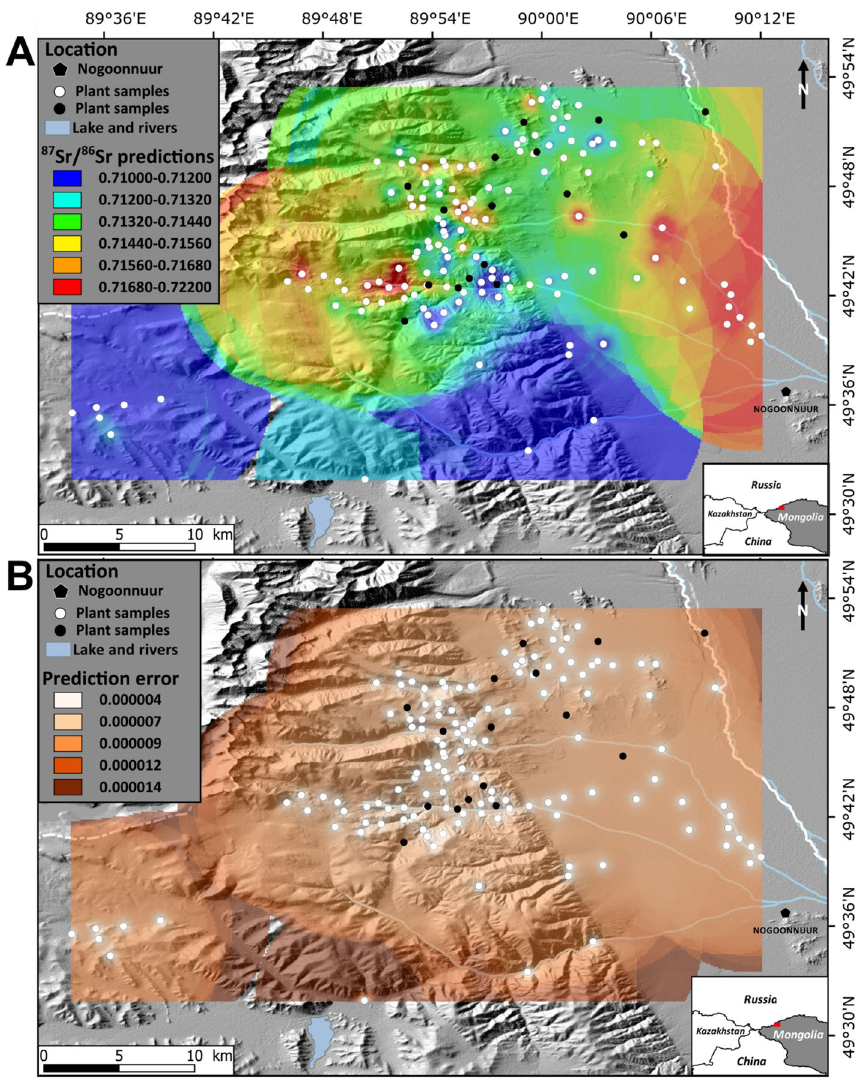
Figure 1. Bioavailable 87 Sr/ 86 Sr of the study area, near the village of Nogoonnur, western Mongolia. 87 Sr/ 86 Sr isoscape ( A ) and its associated predicted error ( B ) were created using QGIS 3.2 Bonn 51 with the predictive model of bioavailable 87 Sr/ 86 Sr built with the kriging function in ArcGIS 10.0 (Environmental Systems Research Institute) 52 . White circles represent the bioavailable 87 Sr/ 86 Sr sampling localities used to create the model. Black dots represent the 16 randomly selected sampling locations that were extracted prior to model development and later used to test the model predictions. Colors indicate areas of lowest bioavailable 87 Sr/ 86 Sr (blue) to highest bioavailable 87 Sr/ 86 Sr (red) for the top panel and lowest predictive error (light beige) to highest predictive error (brown) for the bottom